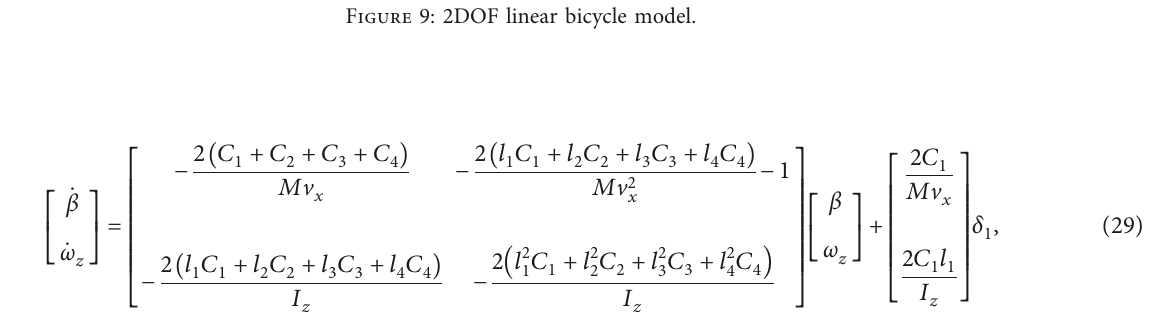
Figure 9: 2DOF linear bicycle model.